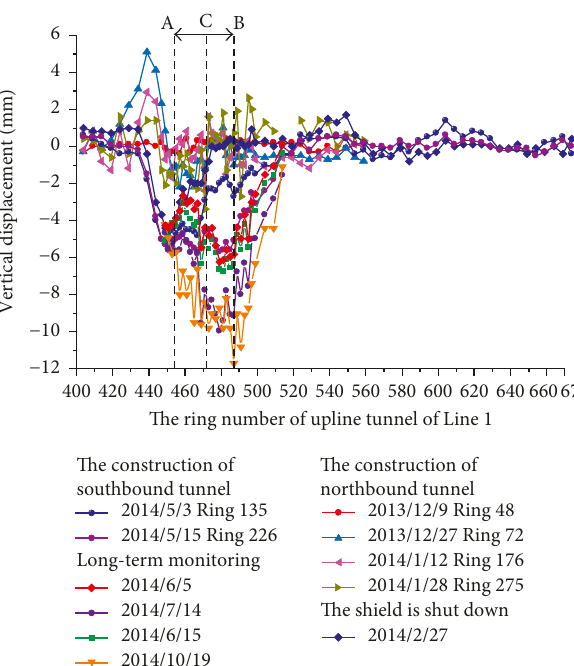
Figure 9: Time-varying vertical displacement of the existing tunnel.